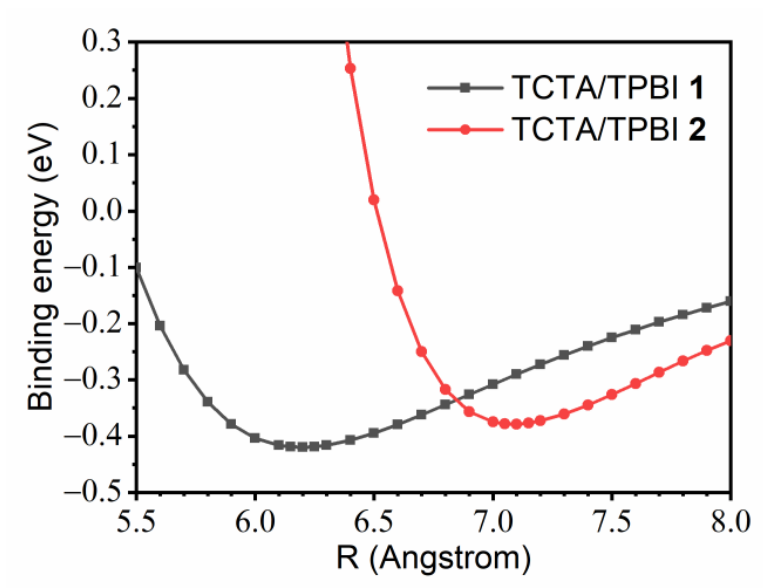
Figure 3. One-dimensional ground state potential energy surfaces of the TCTA/TPBI 1 and 2 as functions of the center-to-center distance between TCTA and TPBI.